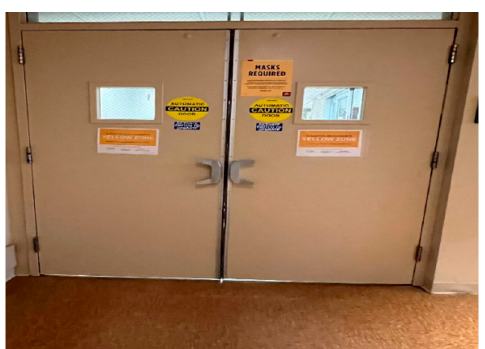
Figure 1. The entrance to the emergency department